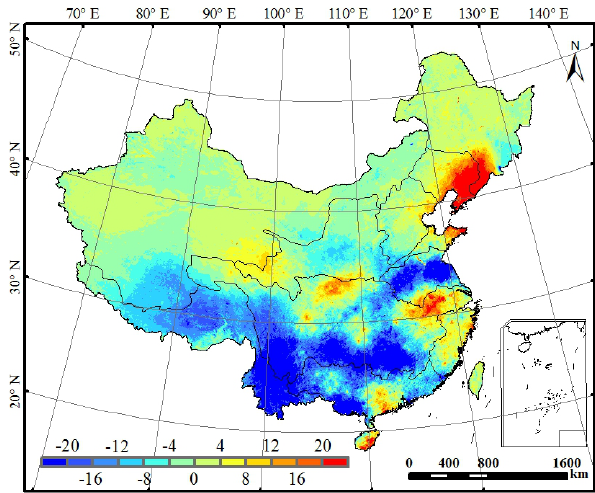
Fig. 11. Temporal trends of water yield in China from 2000 to 2010 (mmyr − 1